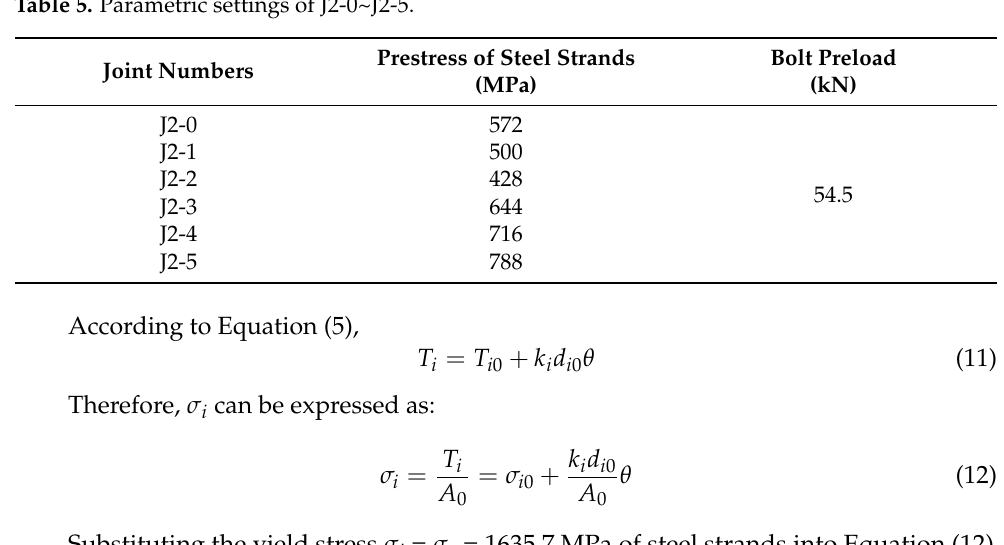
Table 5. Parametric settings of J2-0~J2-5.